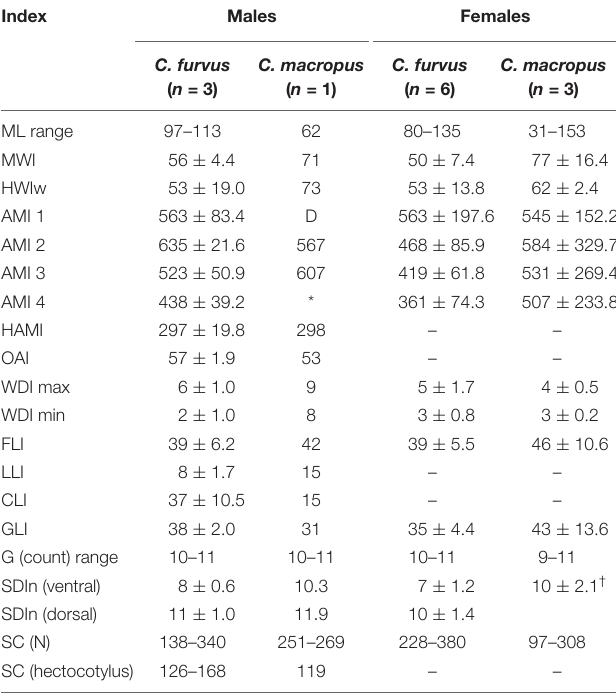
TABLE 6 | Comparison of basic measurement indices for male and female Callistoctopus furvus and Mediterranean C. macropu s stricto sensu (male: 62 mm ML, Villefranche-sur-Mer, France, NHMUK 1952.4.1.43; females: 30 mm ML, Naples, Italy, NHMUK Reg TBC; 47 mm ML, Zoological Station Naples, Italy, NHMUK 1898.5.21.344; and 153 mm ML, “Mediterranean,” NHMUK 1908.12.22.20).